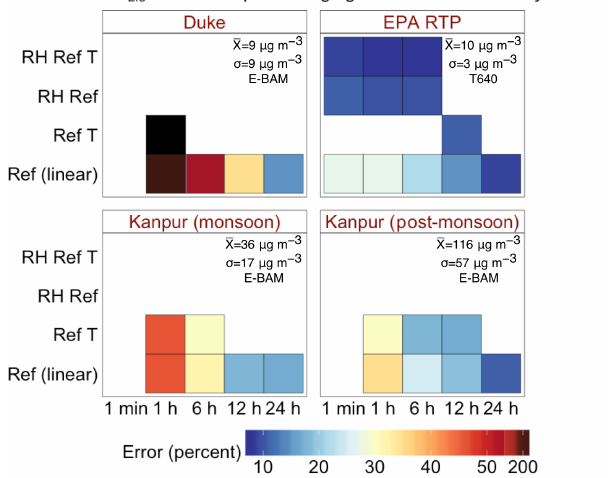
Figure 11. Heat map of the mean errors of the calibrated PMS3003 PM 2 . 5 measurements with respect to averaging timescales and cal- ibration methods across study sites or sampling seasons. The mean and SD of the true ambient PM 2 . 5 concentrations reported by the corresponding reference instrument (Ref) for each location or sea- son were overlaid on the heat map. Note the errors of the 1h E-BAM calibrated and the combination of E-BAM and temperature ( T ) cal- ibrated PMS3003 PM 2 . 5 measurements at the Duke study site were 201% and 207%, respectively. They are represented by dark brown and black, respectively, to improve the visual contrast in